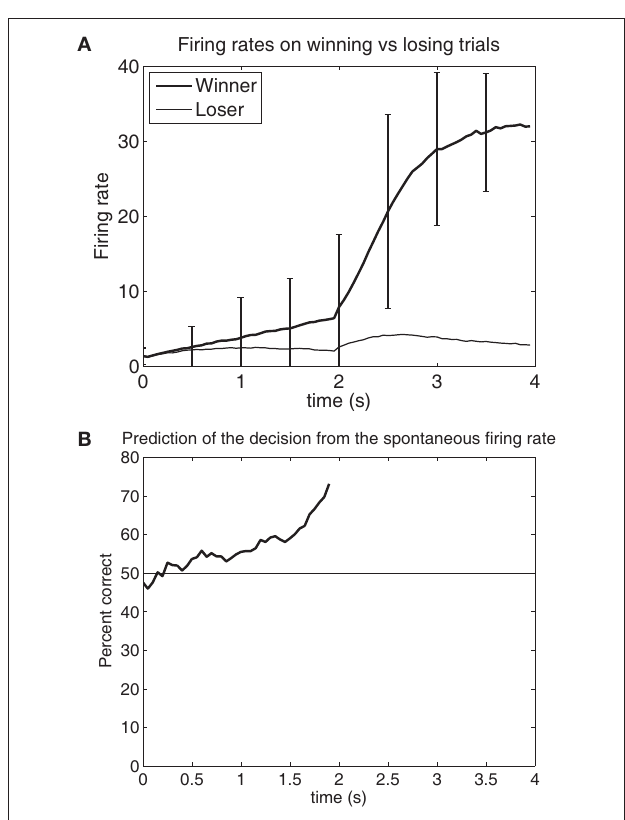
FIguRe 6 | Decision-making in the small network of 500 neurons illustrated in Figure 2 but now with the 290/1000 unstable spontaneous trials included in the analysis (see text). (A) The firing rates averaged over the winning and losing trials. (B) The predictions of the decisions made at different times in the spontaneous period of 0–2 s. The decision cues were applied at t = 2 s. This shows how premature decisions can influence predictions made from activity in the period before the decision cues are